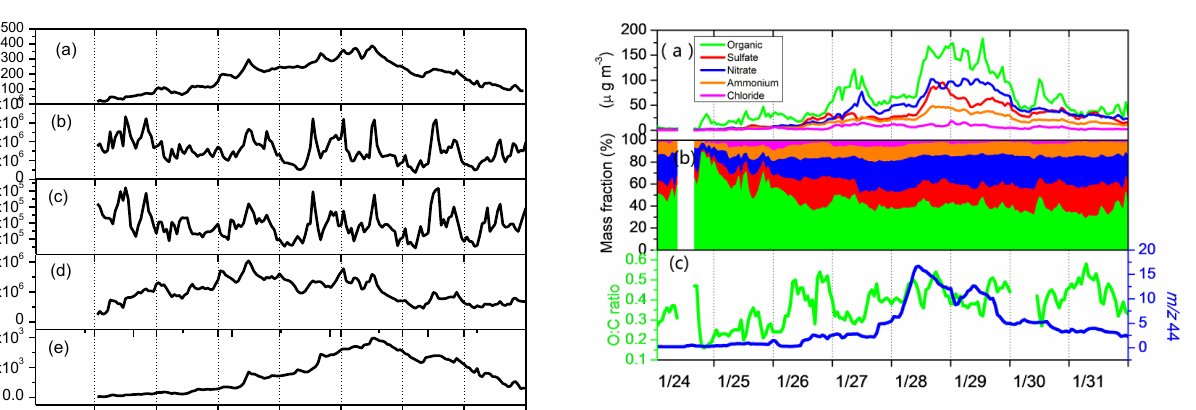
Figure 7. Time series of (a) mass concentrations of organic, sulfate, nitrate, ammonium and chloride in submicron aerosol; (b) mass fractions of organic, sulfate, nitrate, ammonium and chloride; (c) O:C ratio and m / z 44 during the haze